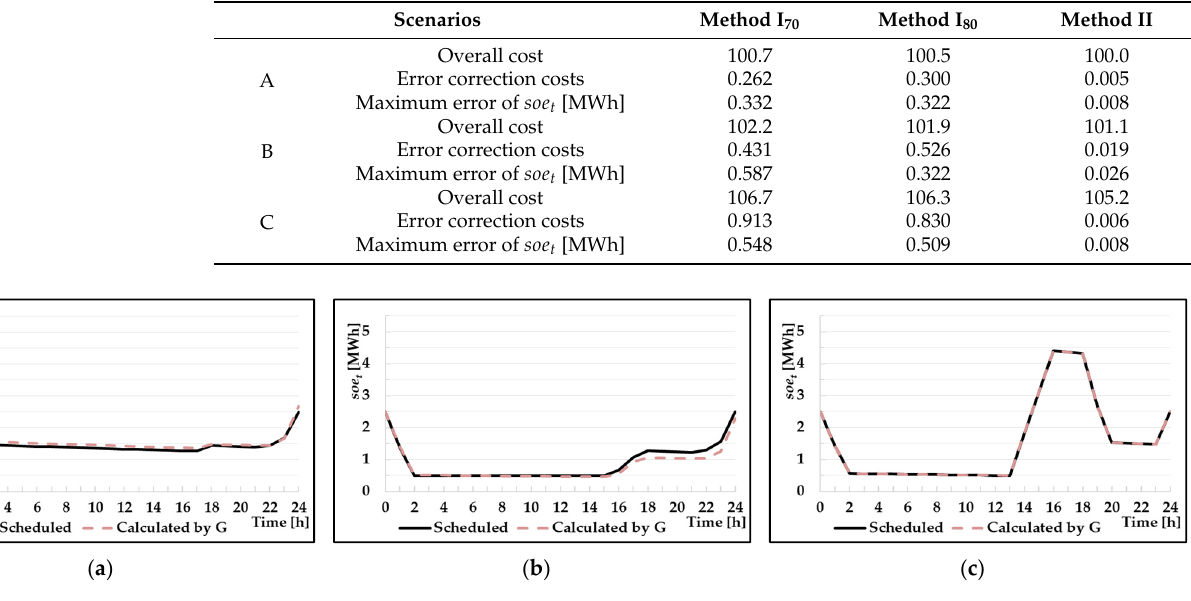
Figure 6. Variations of soe t for Scenario A using methods ( a ) I 70 , ( b ) I 80 , and ( c ) II.